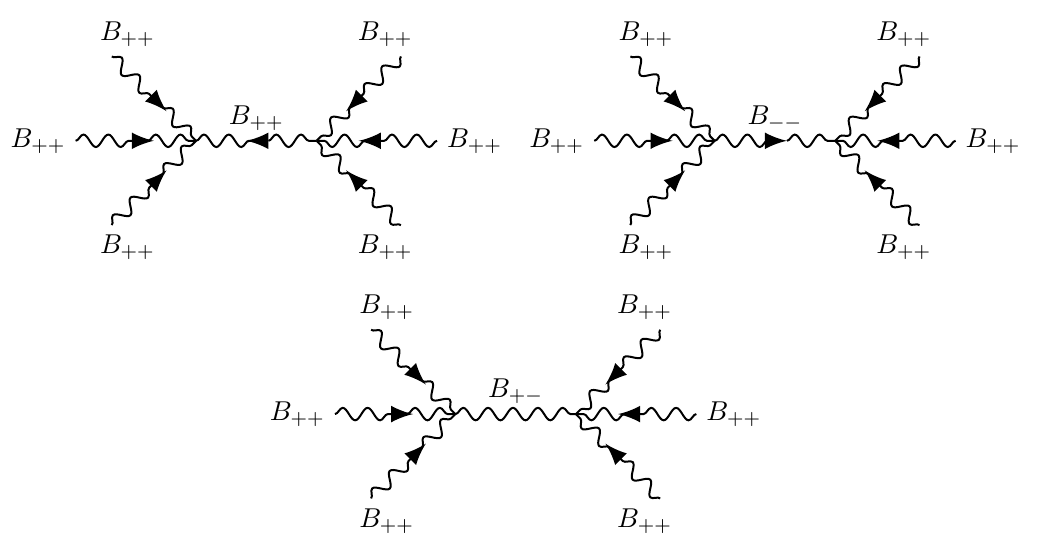
Figure 1 . Exchange diagrams contributing to the 6 B ++ amplitude. The internal line may be any of the three states, and we sum over all the factorization channels as well. It is important to note that these diagrams do not come directly from Feynman rules as there is no covariant action available for the M5 theory; instead, they represent the factorization of the amplitude at the poles where s ijk !